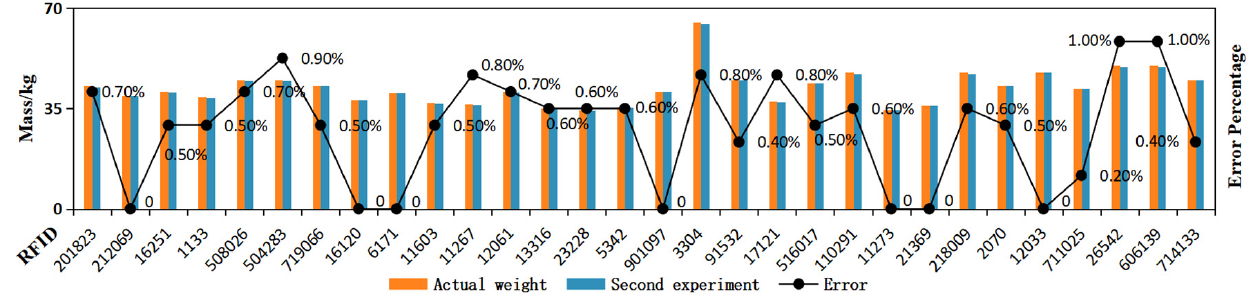
Figure 23. Data plot of the second experiment.